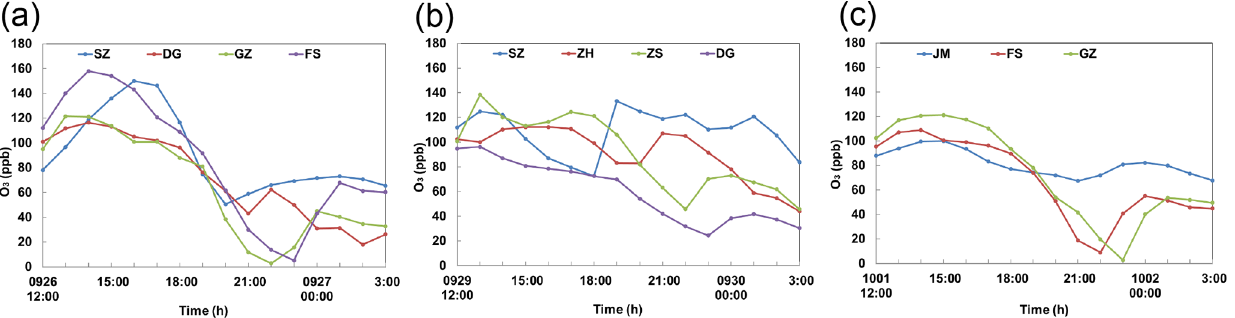
Figure 3. Time series of sites with nocturnal ground-level O 3 rebound in sequence from coast to inland. (a) Time series at SZ, DG, GZ, and FS on 26 September. (b) Time series at SZ, ZH, ZS, and DG on 29 September. (c) Time series at JM, FS, and GZ on 1